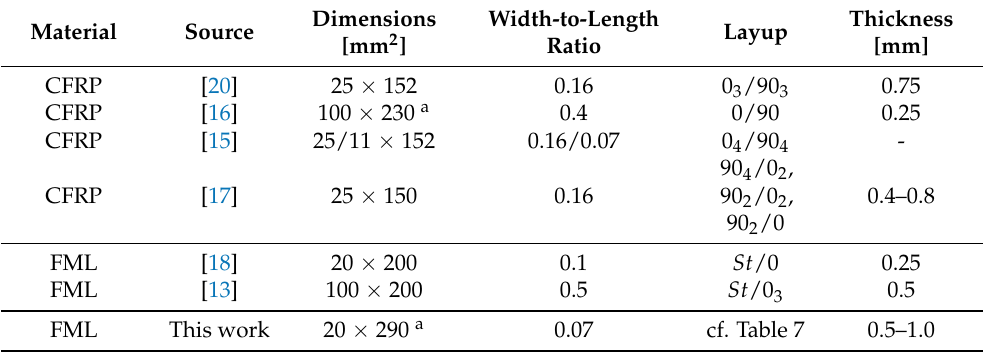
Table 1. Asymmetric specimens made of carbon-fiber-reinforced polymer (CFRP) or fiber metal laminates (FML) used in the literature vary greatly in their dimensions and laminate